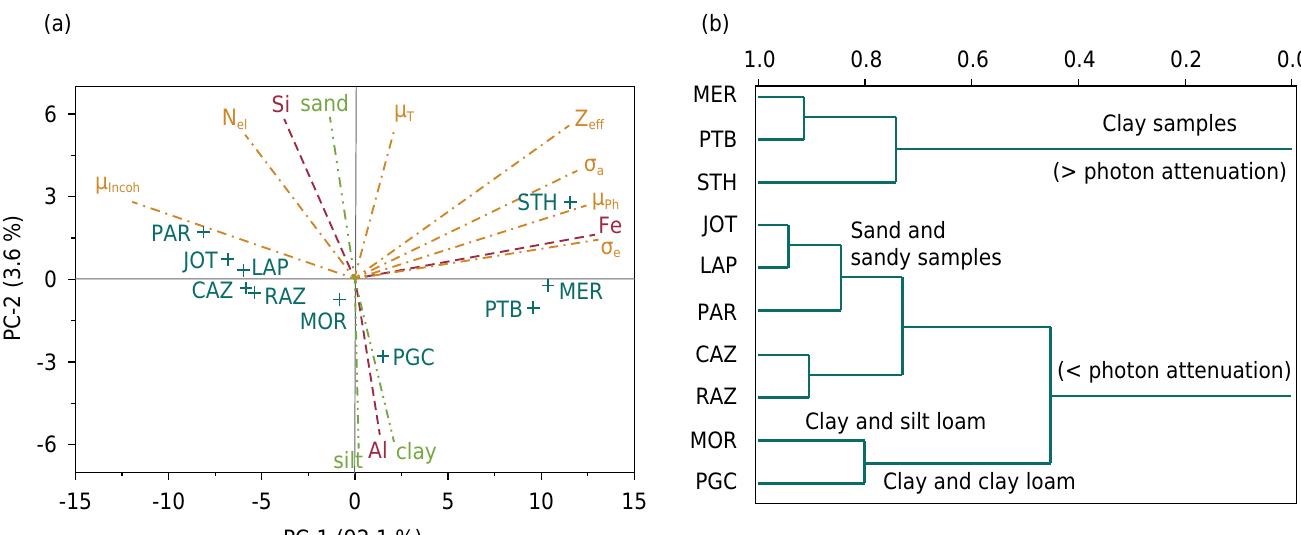
Figure 7. “Scores” of PC-1 and PC-2 of soil samples and their fractions with the inclusion of the following variables: texture (clay, silt and sand percentage), oxide content (SiO 2 , Al 2 O 3 and Fe 2 O 3 ), total mass attenuation coefficient (µ T ), partial mass attenuation coefficient due to the photoelectric effect (µ Ph ), partial mass attenuation coefficient due to the incoherent scattering (µ Incoh ), effective atomic number (Z eff ), electron density (N el ), atomic cross-section (σ a ), and electronic cross-section (σ e ) (a). “Loadings” of the following trends: texture (green lines), oxide content (magenta lines), and radiation interaction with the samples (orange lines). Dendrogram (HCA) for the different soils analyzed with the Euclidian distance, showing the soil samples with the highest and lowest radiation attenuation, influenced mainly by the photoelectric effect and the highest amounts of Fe 2 O 3 (b). The acronyms utilized stand for the following municipalities: PTB (Pato Bragado), PGC (Ponta Grossa), STH (Santa Helena), MER (Mercedes), MOR (Morretes), RAZ (Rio Azul), LAP (Lapa), CAZ (Cerro Azul), JOT (Joaquim Távora), and PAR